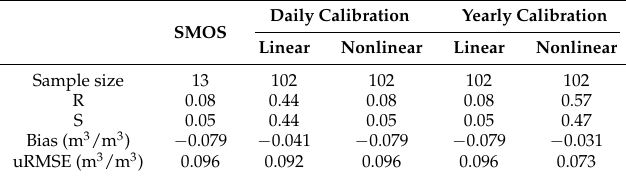
Table 5. Same as Table 4, but for Urgell 2015.